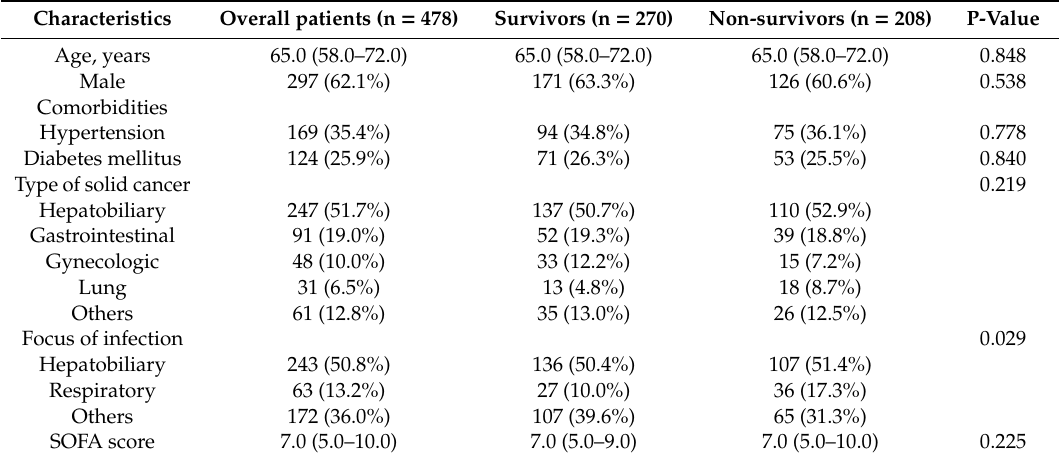
Table 1. Demographic and clinical characteristics of study patients according to 90-day mortality.